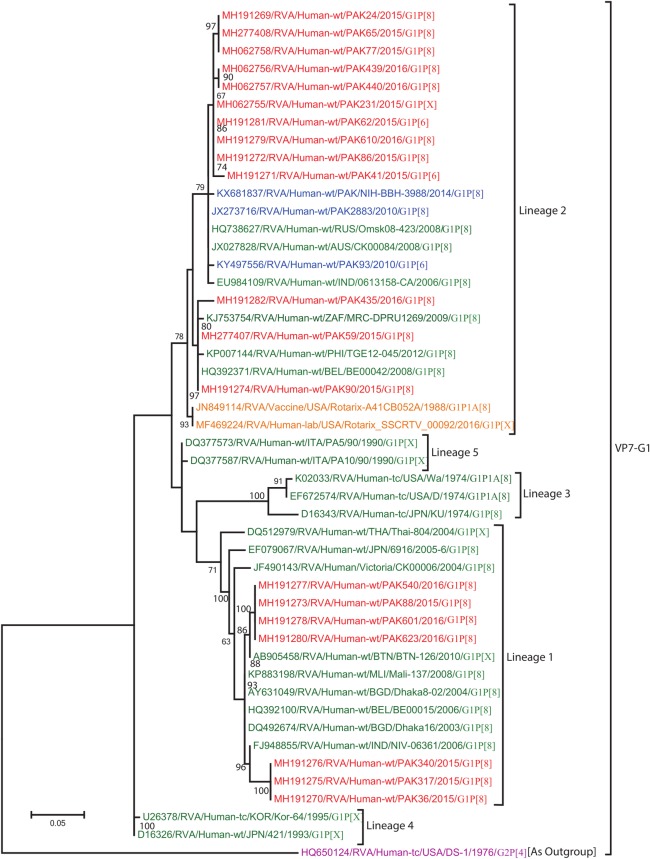
Maximum likelihood phylogenetic tree constructed from the nucleotide sequences of G1-VP7 strains and representative RVA strains with kimura-2-parameter model in mega program 6.0.Bootstrap values <60 are not shown. RVA strains sequenced in this study are represented by the red colour. Pakistani strains reported in the previous studies are shown in blue. The vaccine strains and an out group strain are represented by purple and orange color, respectively while green shading represent strains isolated all over the world. The RVA strains sequenced in this study and reference strains obtained from GenBank database are represented by Accession number, Strain Name, Country and year of Isolation. Scale bar: 0.05 substitutions per nucleotide.